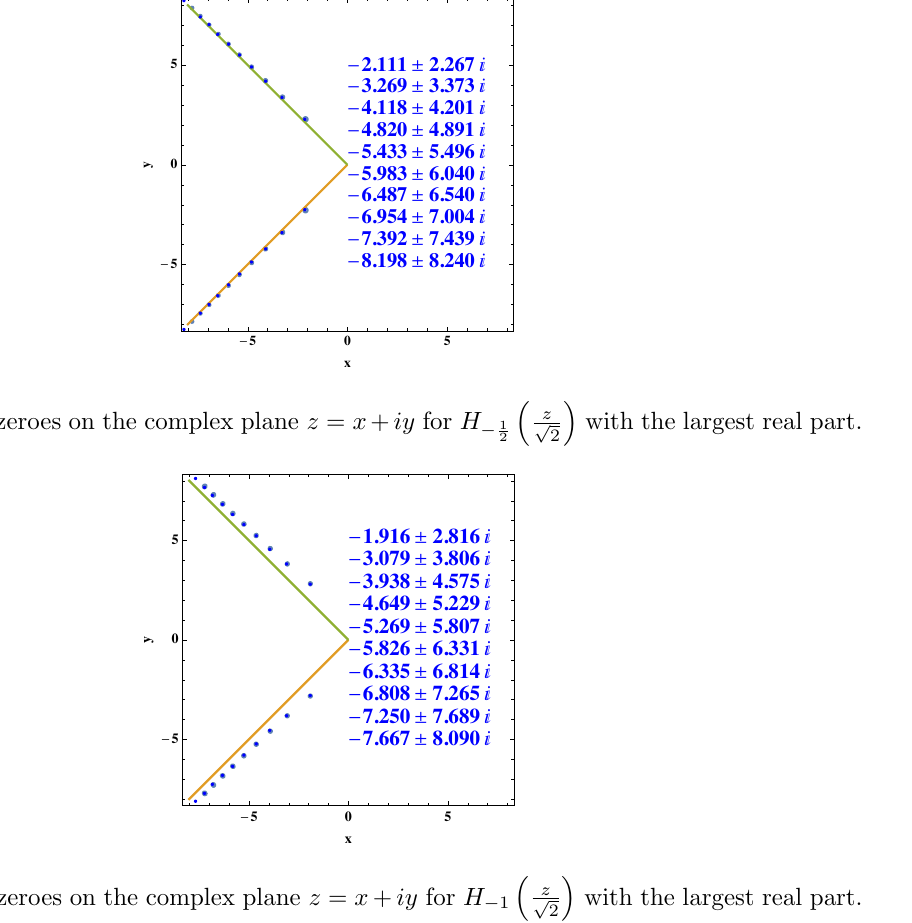
and below the line with argument equal to 5 (cid:25) 4